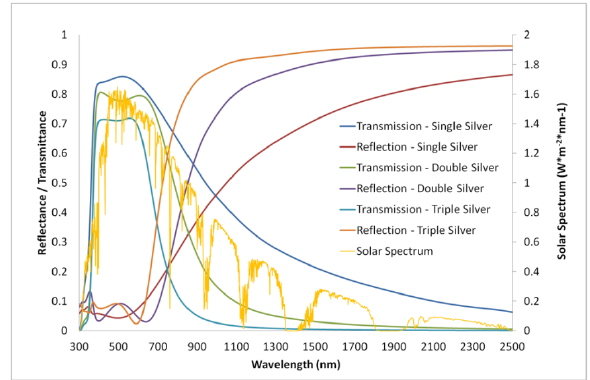
Fig. 14. Spectral reflectance and transmittance of single and multi- ple (oxide/Ag/oxide) units on glass relative to the solar spectrum. More units have a sharper transition where the eye stops sensing, resulting in higher near-IR reflectance with no major loss of day- lighting